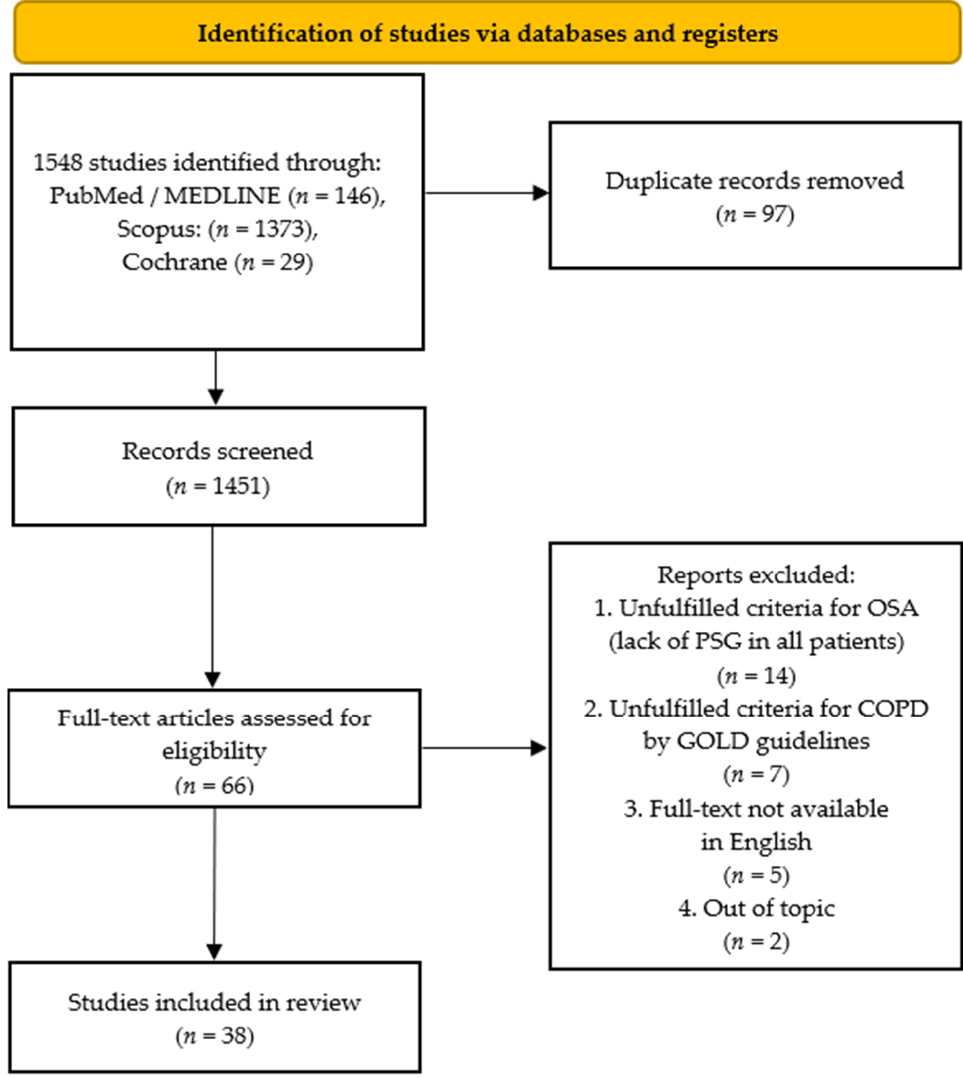
Figure 1. The Preferred Reporting Items for Systematic Reviews and Meta-Analyses (PRISMA) flow diagram of the systematic literature search, showing the study selection process.